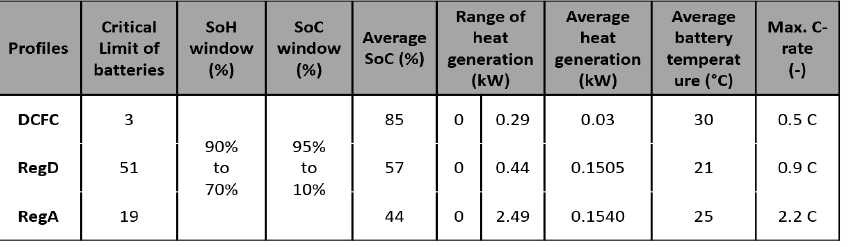
Figure 10. SLB system design and thermal